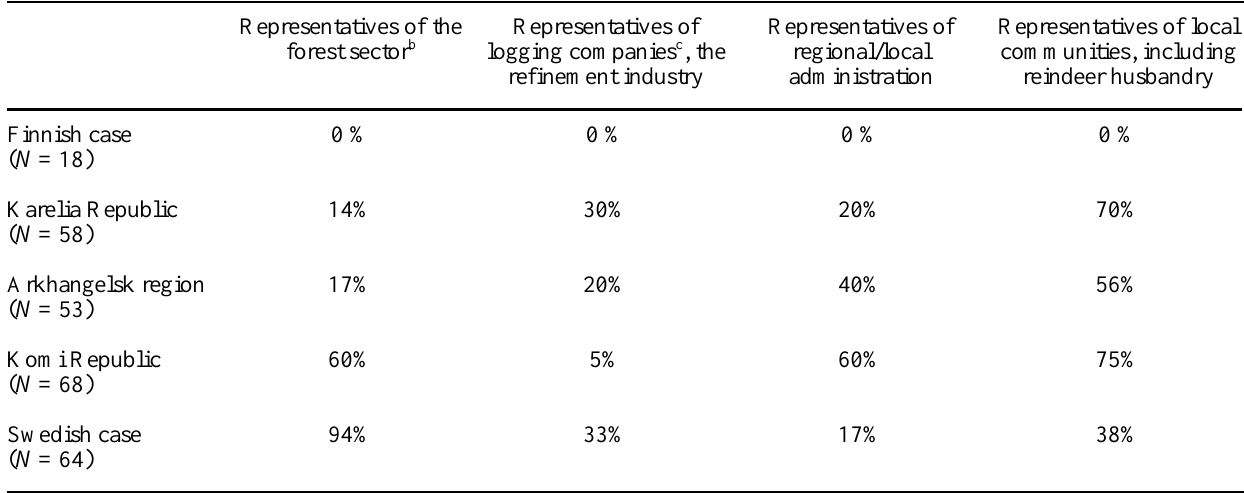
Representatives of the forest sector b